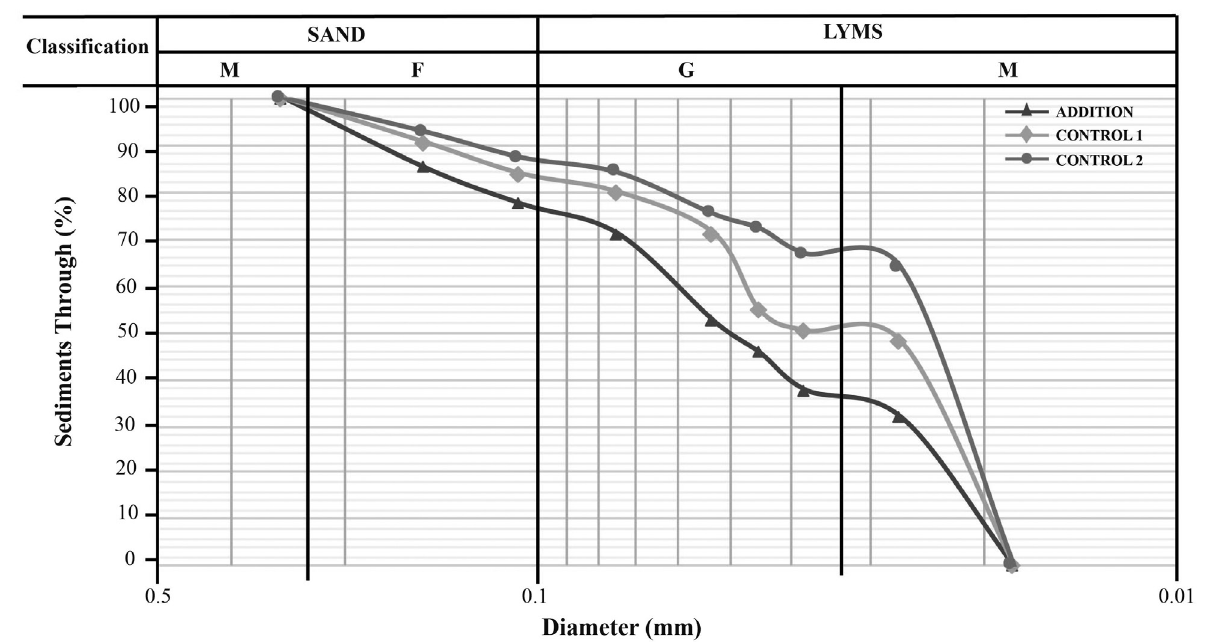
Fig. 4. – Comparison of the granulometric distribution curve found in the different treatments, where G is gross, M is medium and F is fine. The scale of the graph was adapted from Espinace (1979).